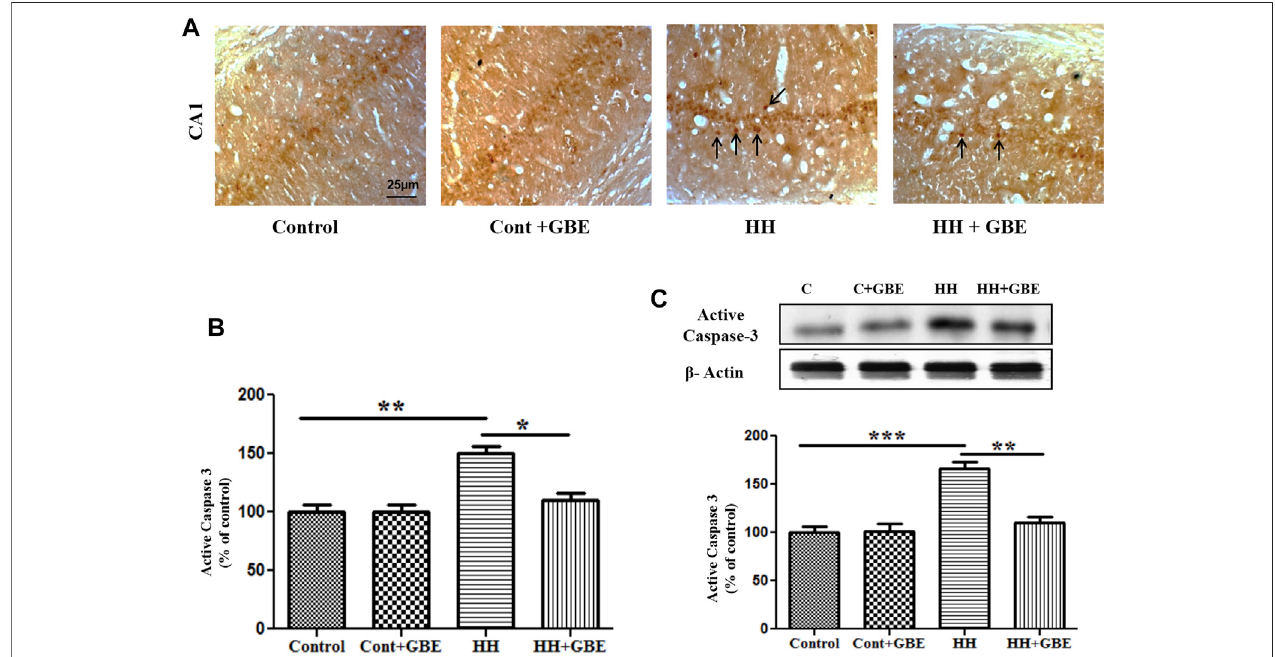
FIGURE 5 | GBE reduces HH-induced apoptosis in the hippocampus. Images show the caspase-3 – positive cells in different groups (A) . Graphical representation indicatestheincreasednumberofcaspase-3 – positivecellsin14 daysofHHexposure,whereasGBEsigni fi cantlyreducedthecaspase-3 – positivecellswhencompared to the HH group (B) . Black arrows indicate activated caspase-3 – positive cells. Immunoblot results also indicate reduced expression of active caspase-3 in groups treated with GBE when compared to the HH group (C) . One-way ANOVA with the Bonferroni test was used to analyze the data. Data are represented as mean